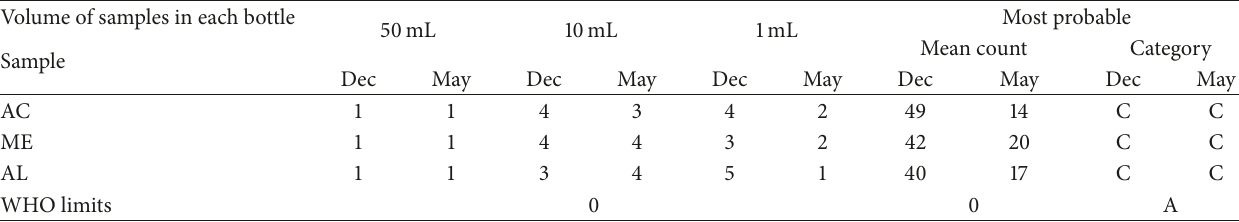
Table 4: Results of bacteriological analysis (most probable number of faecal coliforms).